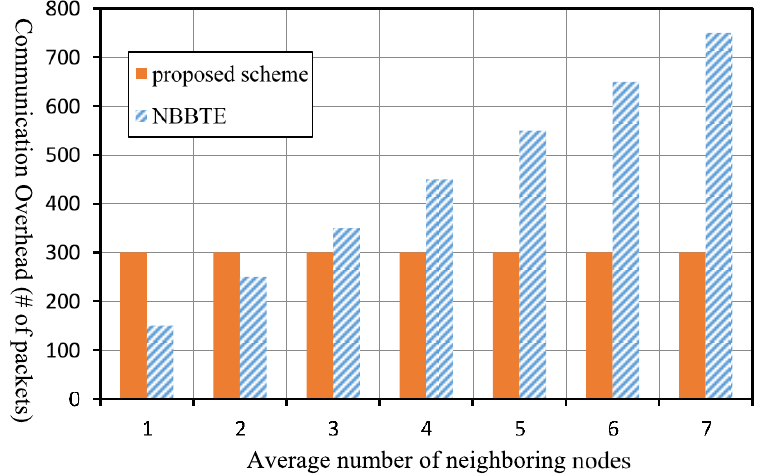
Figure 11. Comparison of the communication overhead under different number of neighboring